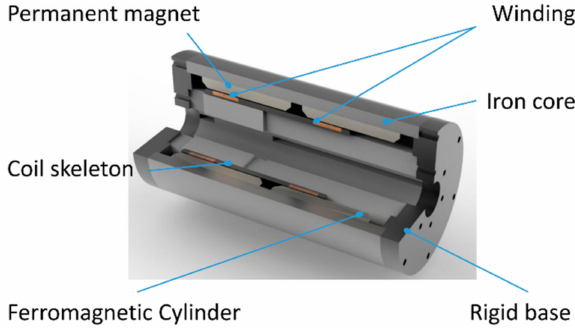
Figure 2. The 3D structure of voice coil